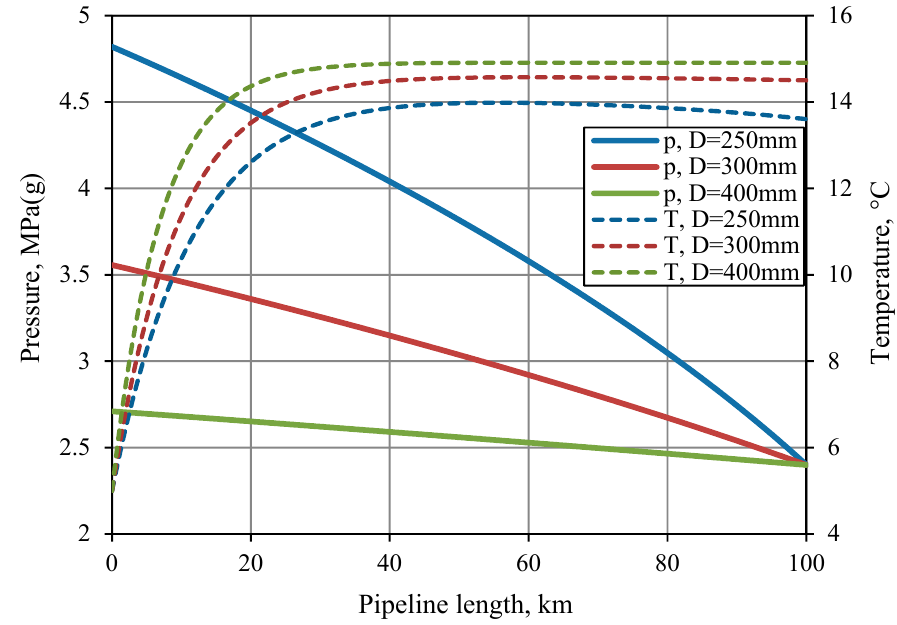
Figure 14. Pressure ( p ) (continuous lines) and temperature ( T ) (dashed lines) changes for methane–15% hydrogen mixture mass flow rate of 6.93 kg/s (40,000 Nm 3 /h) for different diameters.